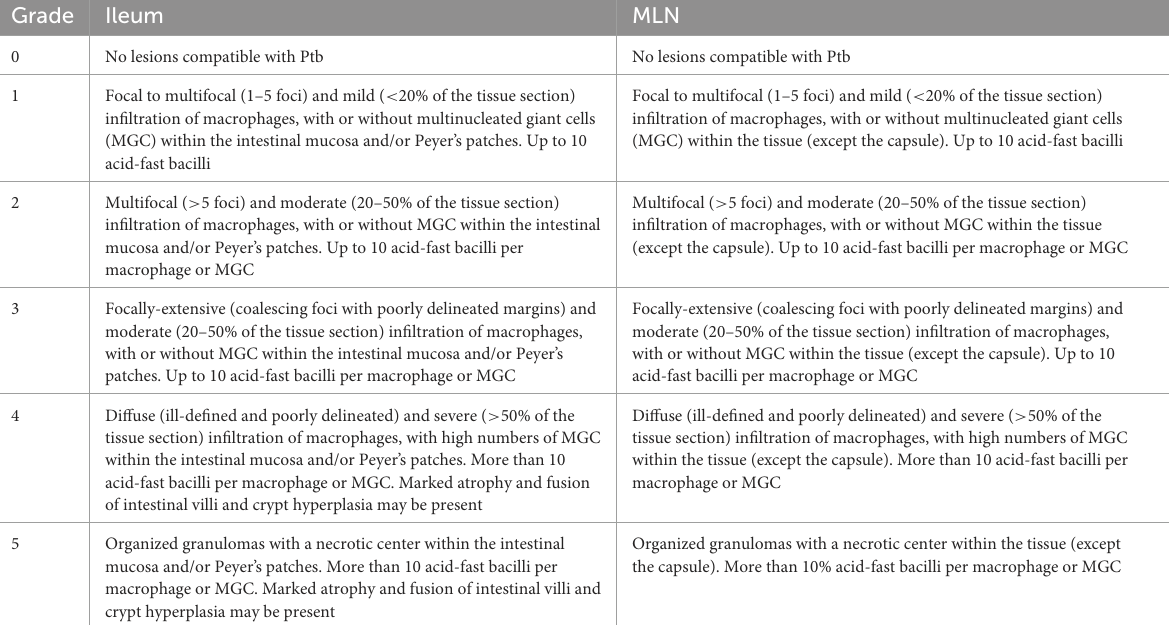
TABLE 1 General criteria description of the histopathological severity score (HSS) system for lesions of ileum and mesenteric lymph nodes (MLN) of dairy cattle infected with Mycobacterium avium subsp. paratuberculosis .